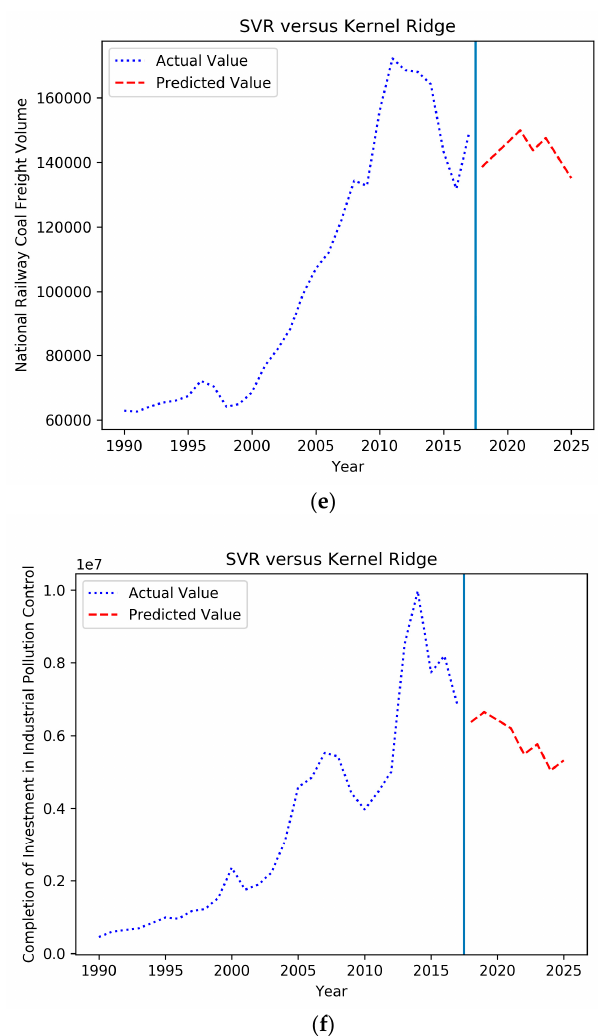
Figure 6. Coal consumption key influencing factors prediction curve. ( a ) Forecasting of consumer price index (CPI); ( b ) forecasting of value added of secondary industry; ( c ) forecasting of urbanization rate; ( d ) forecasting of the proportion of coal consumption to energy consumption; ( e ) forecasting of national railway coal freight volume; ( f ) forecasting of completion of investment in industrial pollution control.